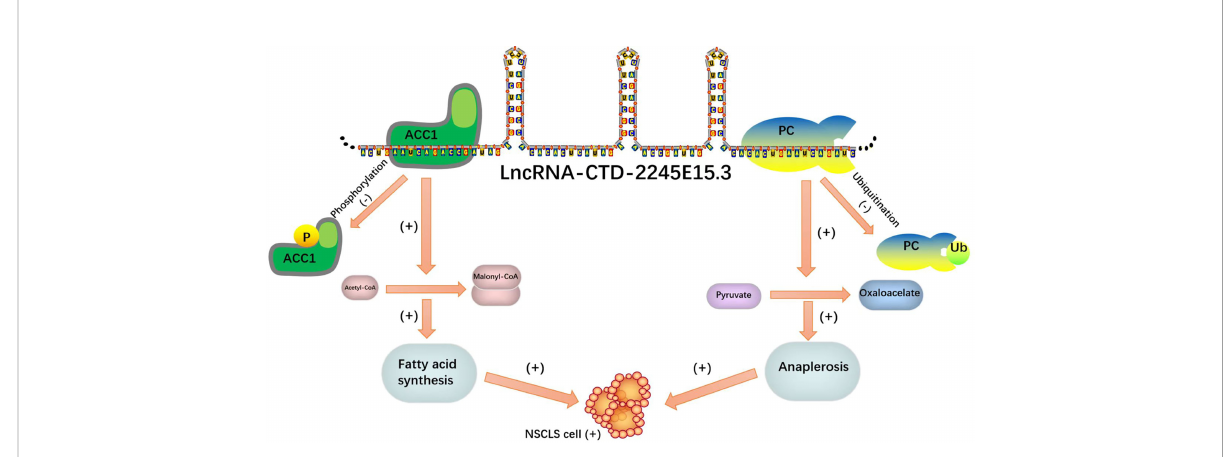
FIGURE 7 As molecular decoys for RNA binding proteins (RBPs).